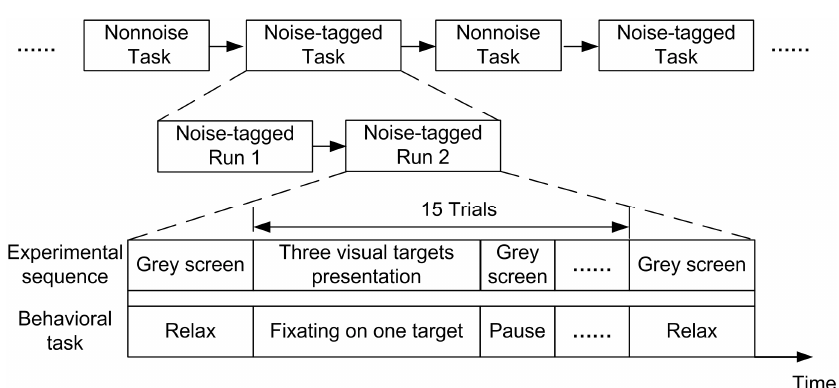
Figure 3. The timing of the experimental sequence and behavioral task. For each participant, the experimental tasks alternated every two runs like “Non-noise run – Non-noise run – Noise-tagged run – Noise-tagged run – Non-noise run – Non-noise run …”.